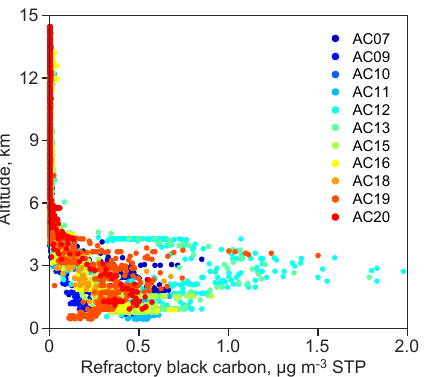
Figure 15. Refractory black carbon vs. altitude for all flights (30s averages).